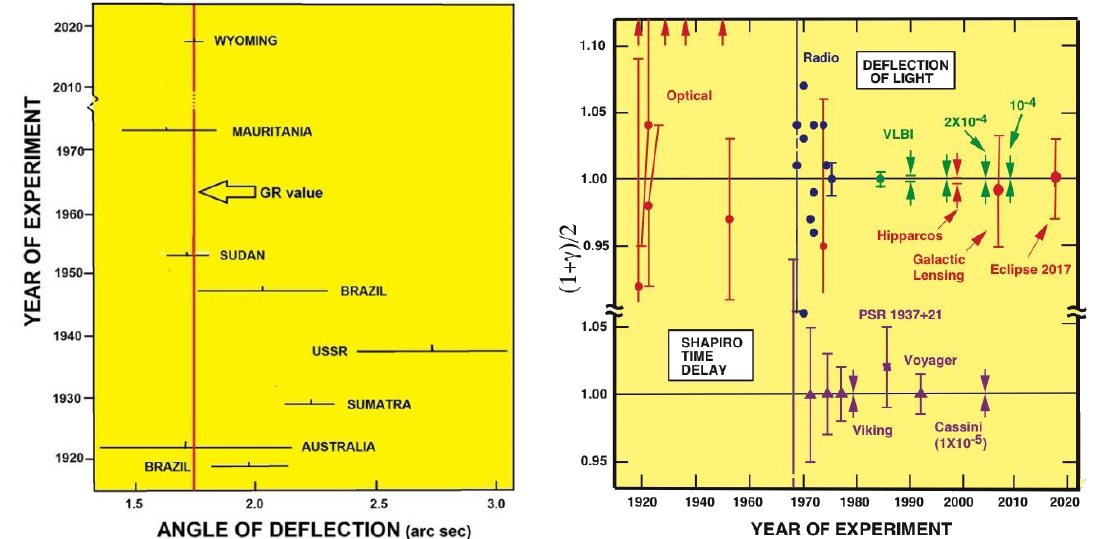
Figure 5. Left panel: Measurements of the angle of light deflection by the Sun. The red dashed line indicates the value given by GR. Right panel: Measurements showing how well GR is confirmed and providing additional constraints of the coefficient (1 + γ)/2 from light deflection and time delay observations. For GR γ = 1. In modified gravity the bending angle by the Sun would be δθ ≈ 1.7505” (1 + γ)/2. The arrows at the top denote anomalously large values from early eclipse expeditions. The Shapiro time-delay measurements using the Cassini spacecraft yielded an agreement with GR to 10 −3 percent, and VLBI light deflection measurements have reached 0.01 percent. Hipparcos denotes the optical astrometry satellite, which reached 0.1 percent. Credit right panel: C. M. Will, updated figure from the one in [42].